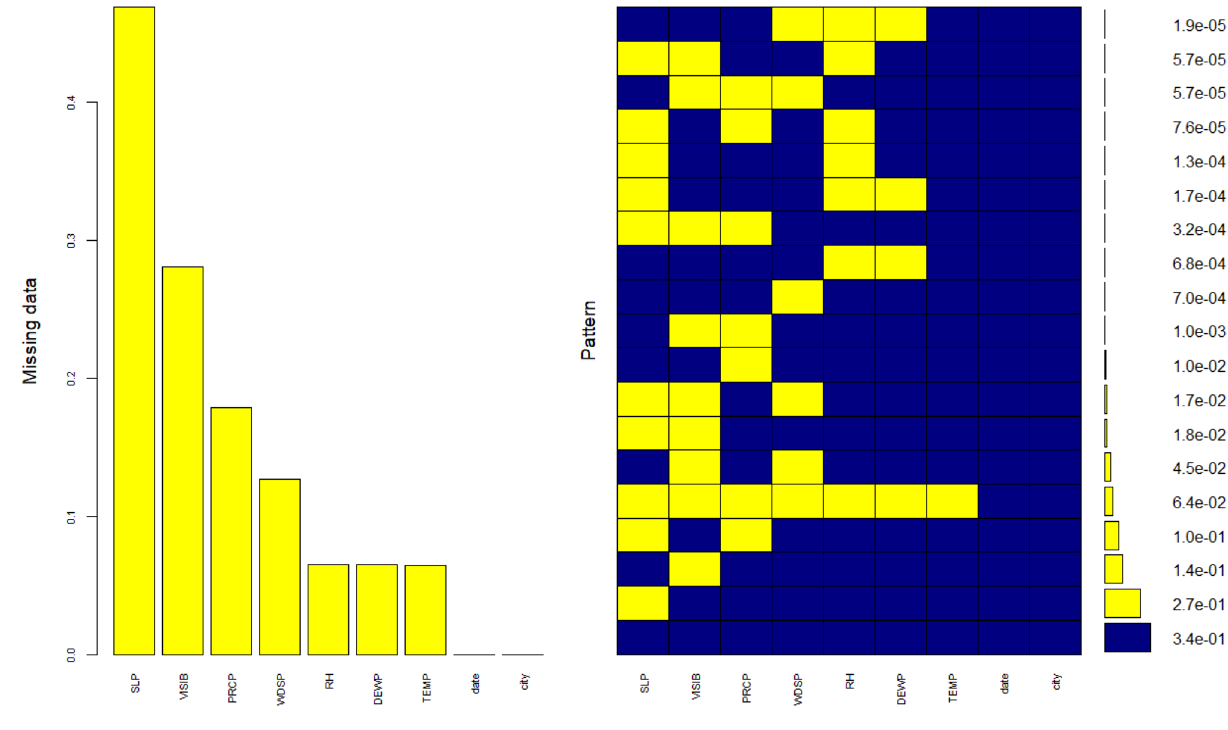
Figure 4. Patterns of missing